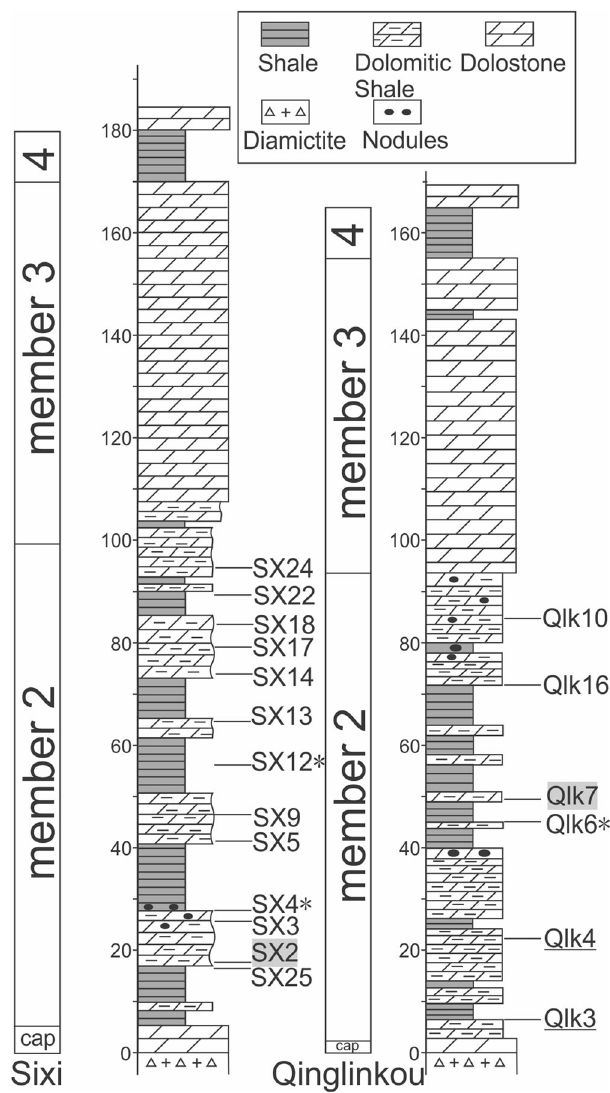
Fig. 2 Lithological logs of the Sixi Section and Qinglinkou Section with sample positions shown. Two representative samples chosen for EPMA are denoted in grey shade; Asterick denotes samples containing potential phosphatic fossils. Underlined samples have unusual petrographic features and are not further considered for the present study: Qlk3 comprises laminated illite and quartz and Qlk4 is completely